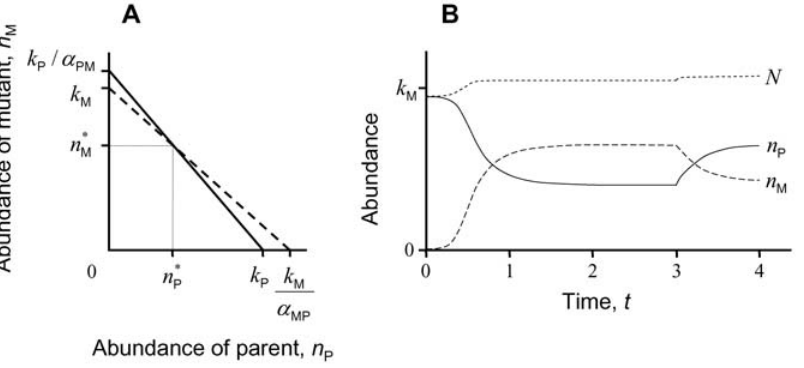
Figure 2. Equilibrium coexistence of a sexually reproducing parent population n P invaded by an asexual mutant, n M . With the mutant having identical vital rates except for twice the intrinsic propagation rate per capita: b M =2 ? b P , the parent species persists if a PM , k P /k M . (A) Phase plane. (B) Equilibration of abundances over time given by Equation 1, with a 50% drop in the parent’s intrinsic death rate imposed at t =3 to illustrate approximate constancy of N = n M + n P